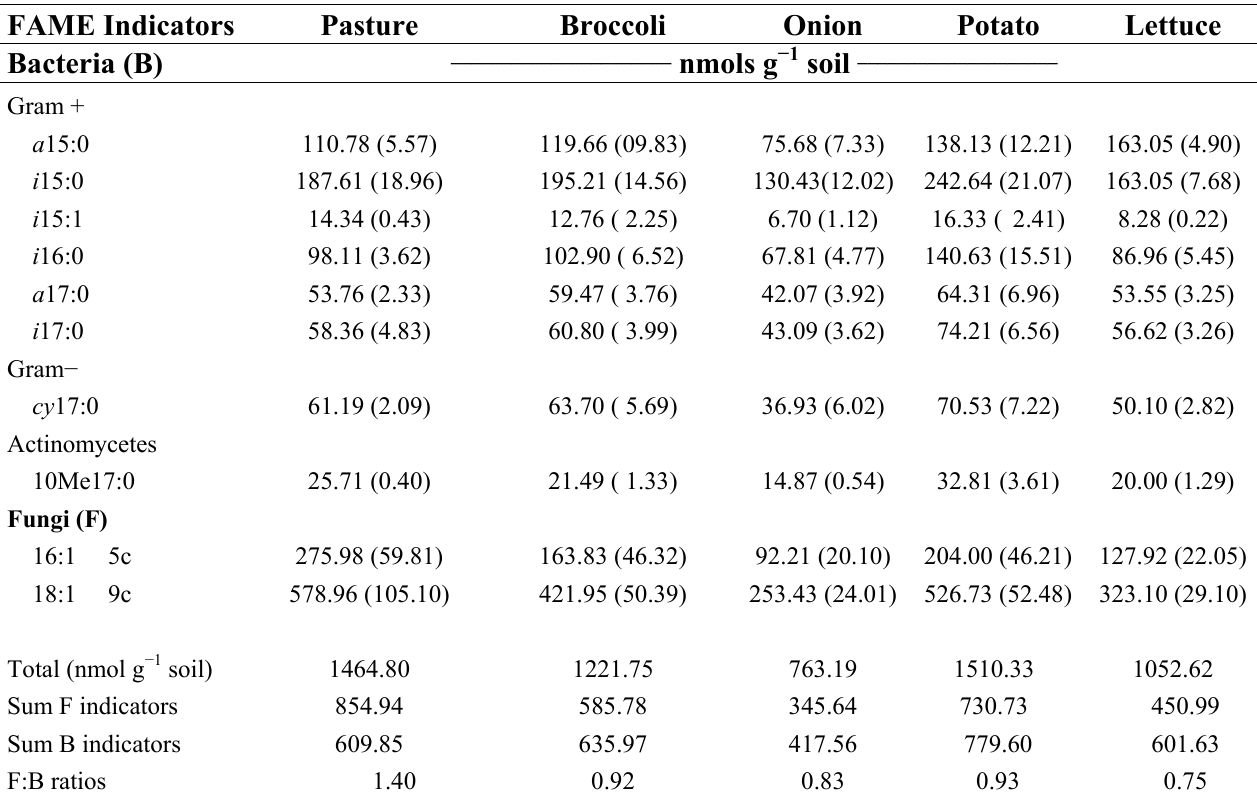
Table 2. Soil microbial community composition according to FAME indicators under different rhizospheres in an organic production system (0–10